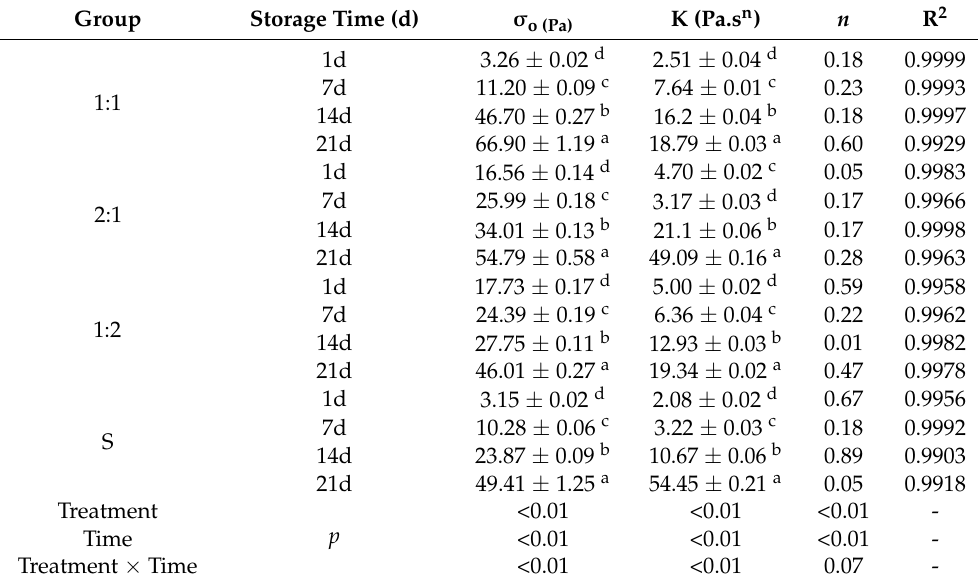
Table 3. Rheological parameters were obtained using the Herschel–Bulkley model for yogurt samples during storage at 4 ◦ C. “a, b, c, d” indicate significant differences within yogurt groups during storage at p < 0.05.